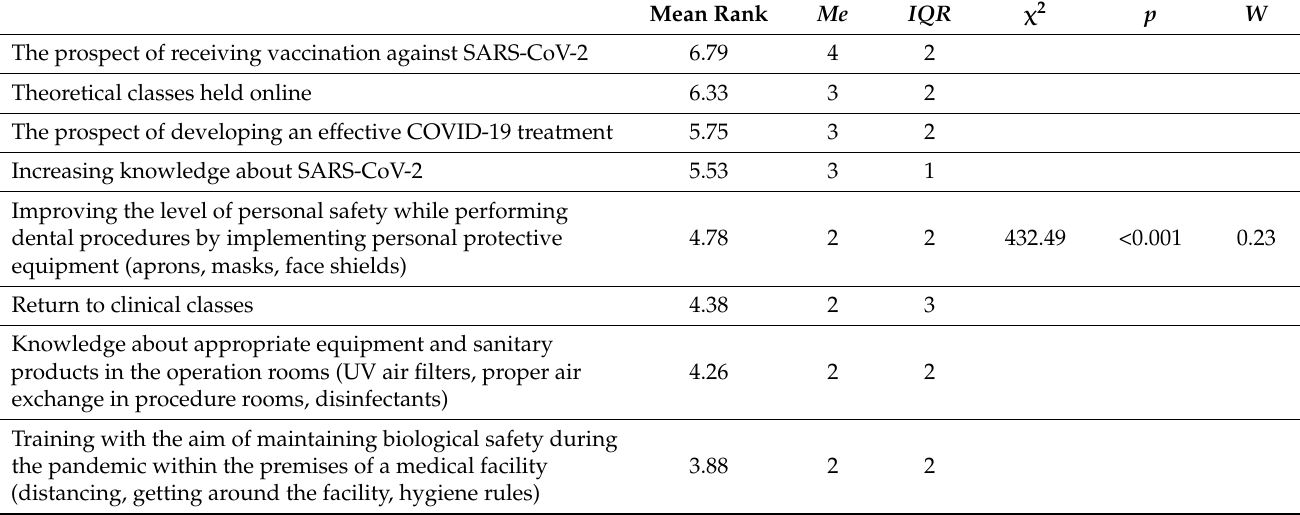
Table 1. Friedman’s analysis comparing the influences of the implemented preventive activities on stress perception among students of dentistry at JUMC during the COVID-19 pandemic.